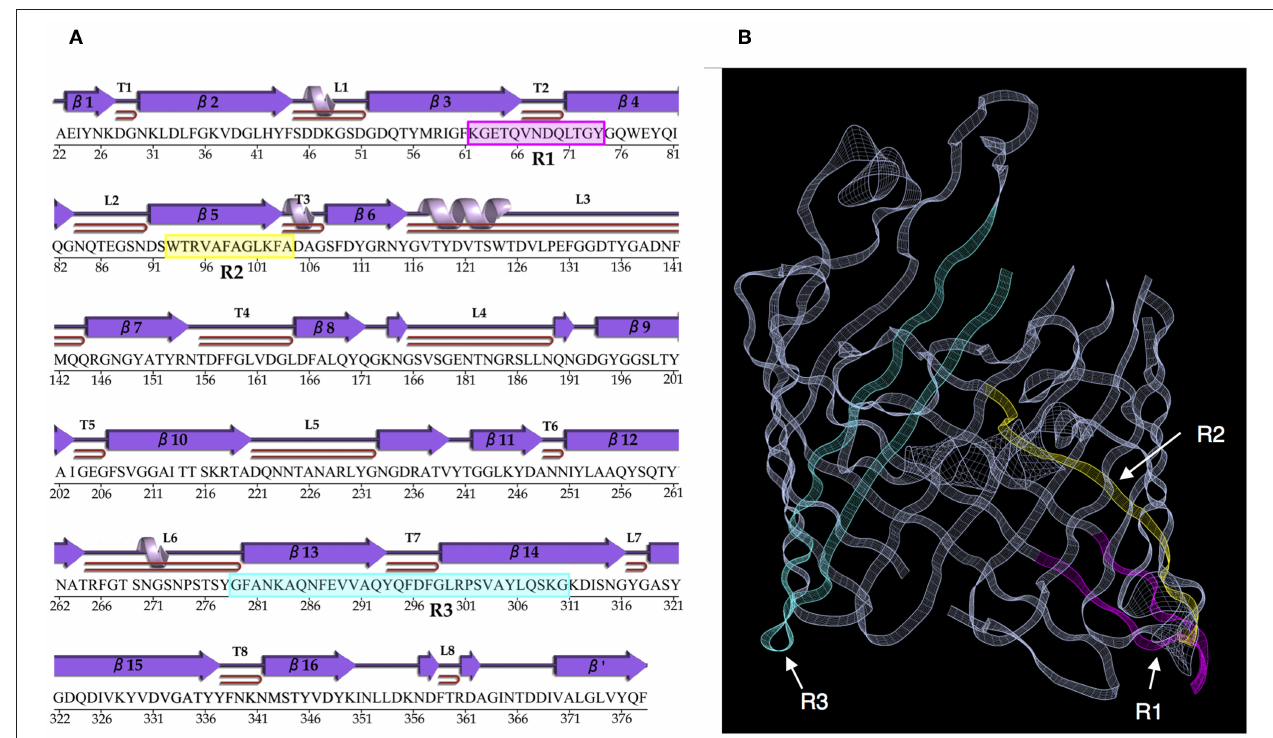
FIGURE 3 | The amino acid sequences conserved among Salmonella OmpC porin clades are located along the β -sheets of the β -barrel. (A) The secondary structure of the S. Typhi OmpC porin was modeled with PDBsum (ID: 3UU2). α -helices and β -sheets are numbered and shown in purple. The periplasmic turns are labeled T1–T8, and the extracellular loops are labeled L1–L8. The porin amino acid sequence is shown without the signal peptide. (B) Crystal structure of a S. Typhi OmpC monomer. (A,B) The conserved regions (R1–R3) among Salmonella clades are highlighted in colors, R1 (magenta), R2 (yellow), and R3 (cyan).